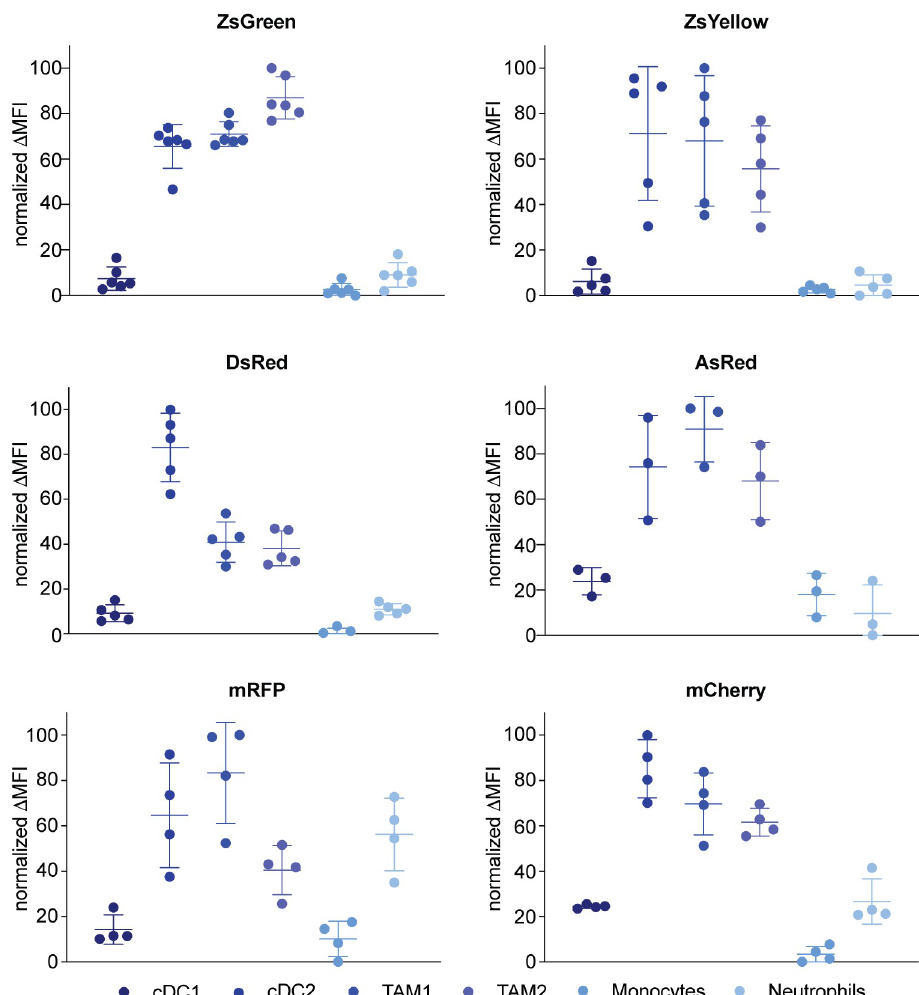
Fig 5. cDC2s and TAMs contain the most fluorescent TAAs per individual cell. Immune cells were purified from the TME of B16 mice bearing B16 tumors with the indicated fluorophors and analyzed for relative antigen uptake. Data was normalized to the maximum delta MFI of each FP for every independent